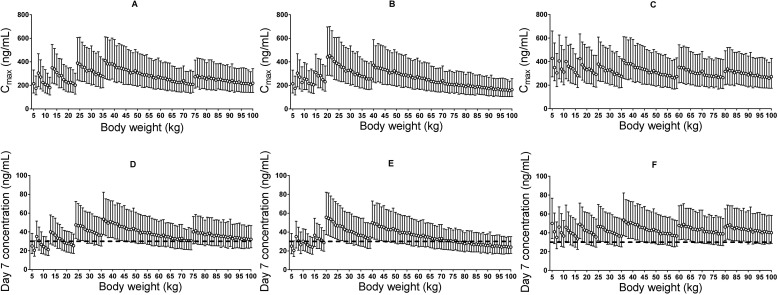
Stochastic simulations of dose regimens.Maximum plasma piperaquine concentration (A–C) and day 7 plasma piperaquine concentration (D–F) after Sigma-Tau’s recommended dosing (left panels), Beijing Holley-Cotec’s recommended dosing (middle panels), and the revised dose regimen (right panels). Circles represent the median values, and vertical lines represent the 25th to 75th percentiles of simulated concentrations. The dashed line indicates the previously defined venous plasma piperaquine day 7 concentration threshold value for therapeutic success of 30 ng/ml [35].